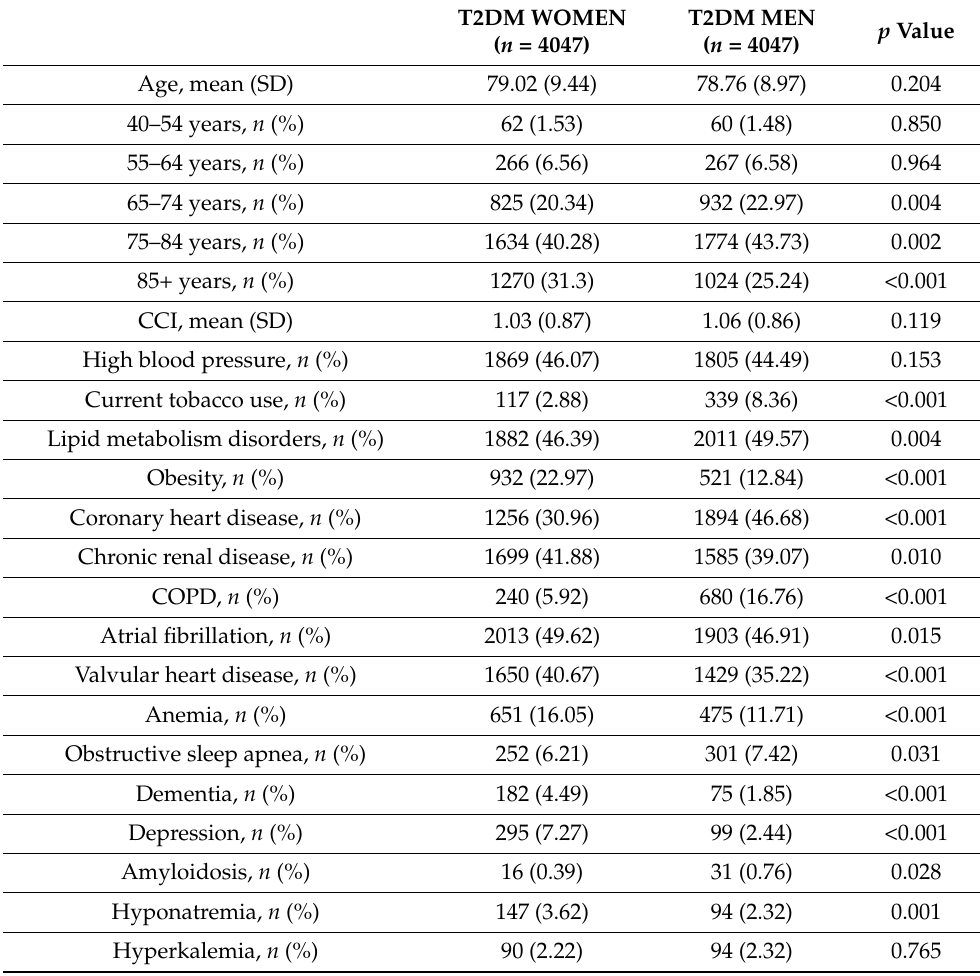
Table 4. Demographic and clinical characteristics, after propensity score matching, of men and women with type 2 diabetes mellitus hospitalized with systolic heart failure in Spain from 2016 to